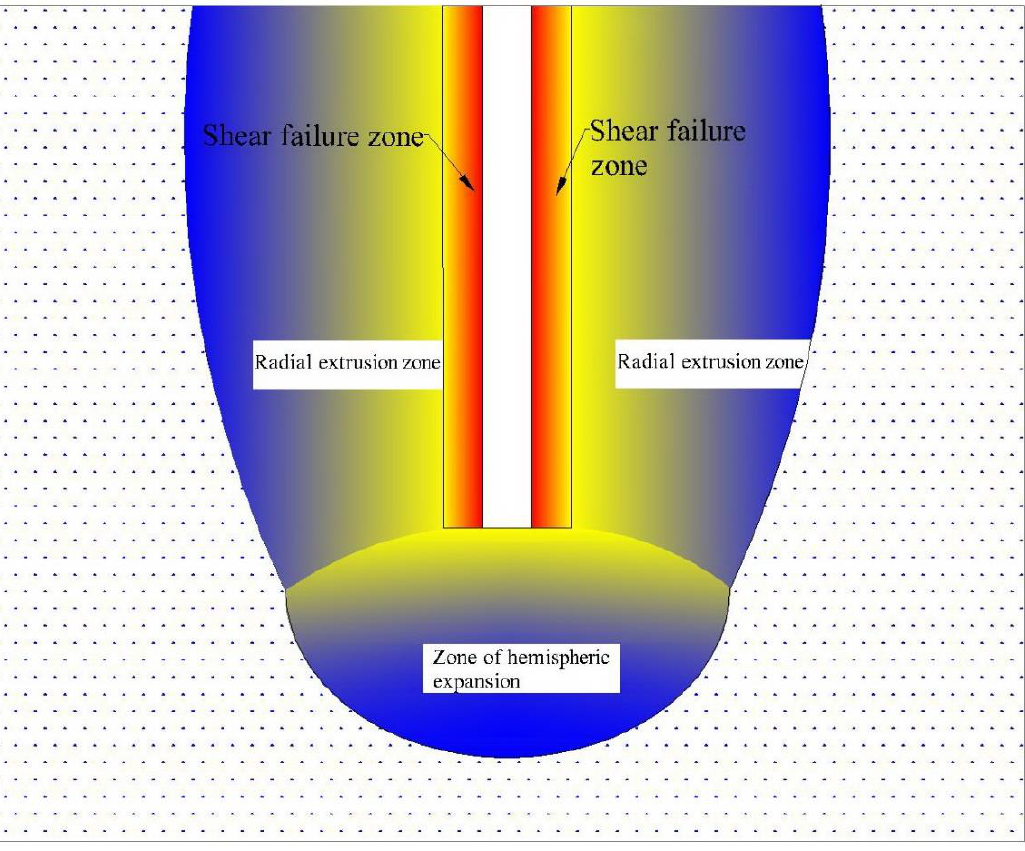
Figure 18. Affect region of a pile penetrating the strata.